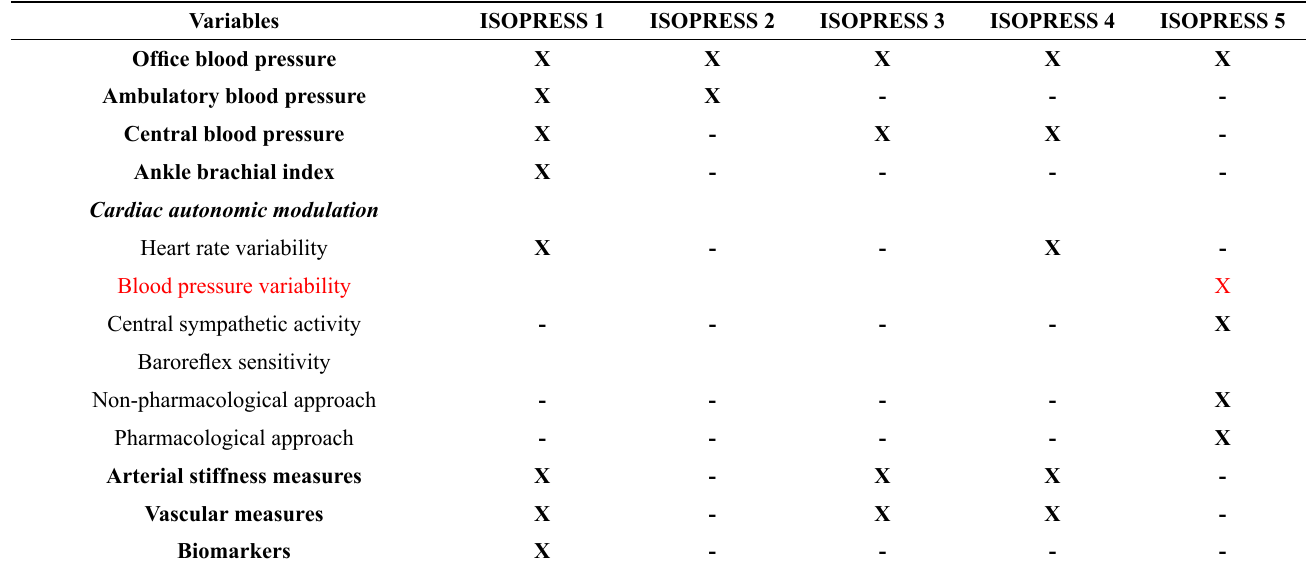
Variables analyzed Table 3 lists the variables obtained in the studies. The measures are standardized between all studies. Prior to all cardiovascular Table 3. Outcomes assessments of ISOPRESS